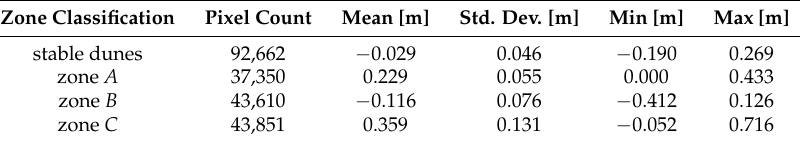
Figure 14. ( a ) DEM of the survey on December 2017; ( b ) DEM of the survey on November 2015; − H ortho ( c ) Computation of the DEM of Difference (DoD) as H ortho . Polygons describing stable Dec .2017 Nov .2015 dunes, zone A , zone B and zone C have been specified. Table 4. Zonal statistics on the selected DoD